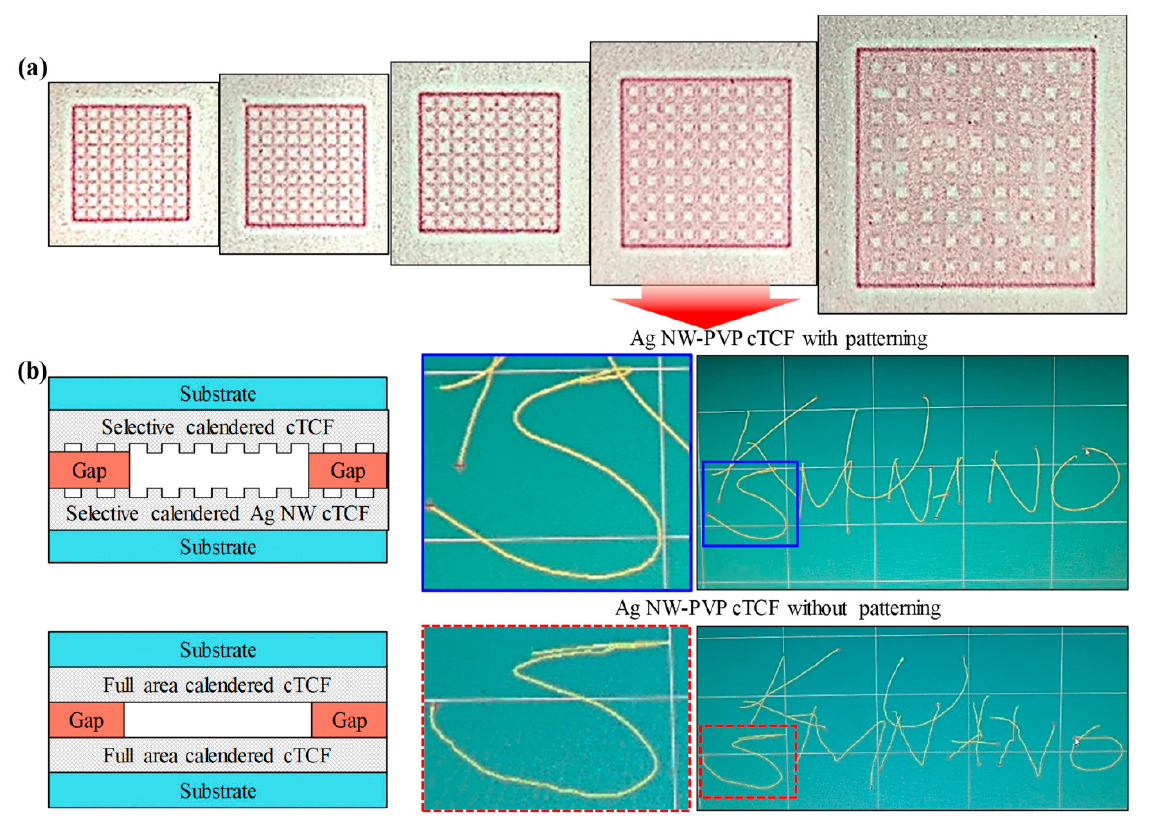
Figure 5. Resistive touch sensing panels fabricated by selective calendering of Ag NW-PVP cTCFs: ( a ) a mesh pattern imaged on pressure-sensitive paper with various line widths, ( b ) a cross-section structure and performance of touch sensing panel between selectively calendered (upper) and full area calendered (bottom) Ag NW-PVP TCF with a mesh pattern. Reproduced from Ref. [33] under